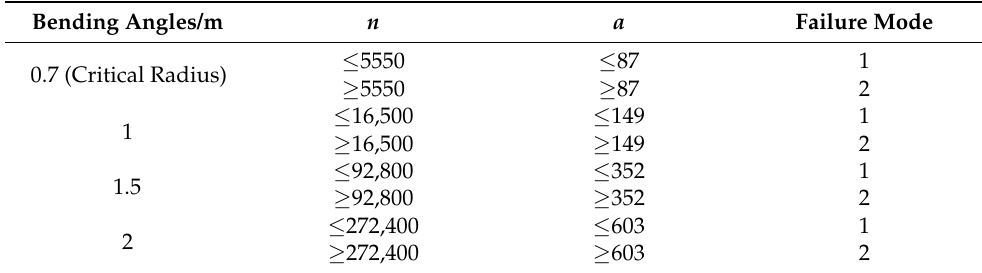
Table 1. Critical number n under the two failure